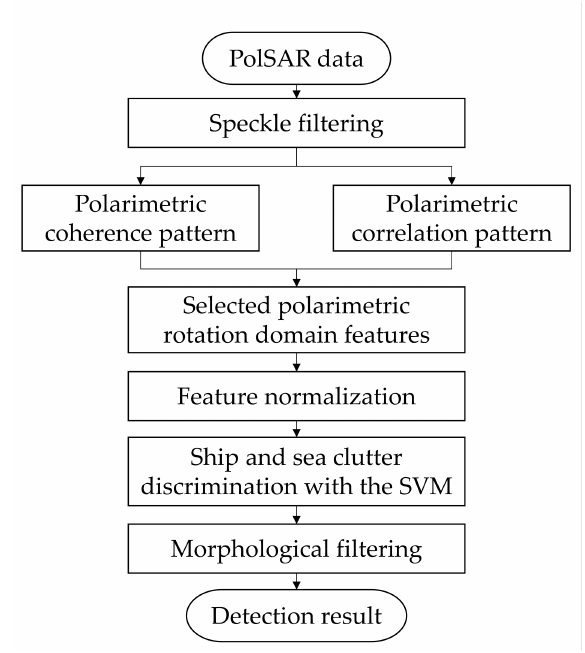
Figure 6. Flowchart of the proposed ship detection scheme.